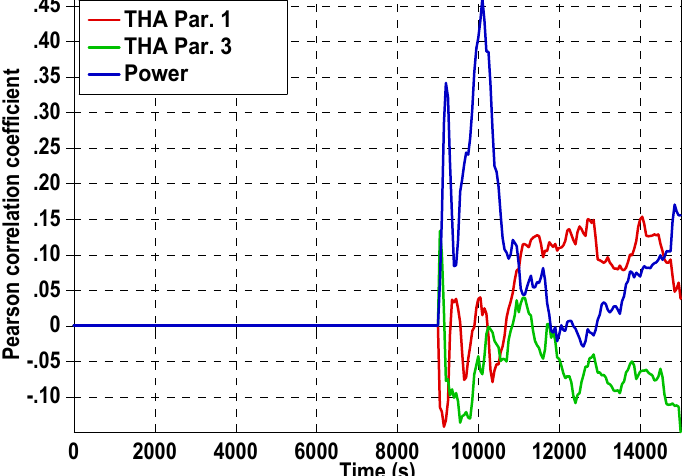
Figure 15. Pearson correlation coefficient between thermal hydraulic input parameters and corium height in the lower head.